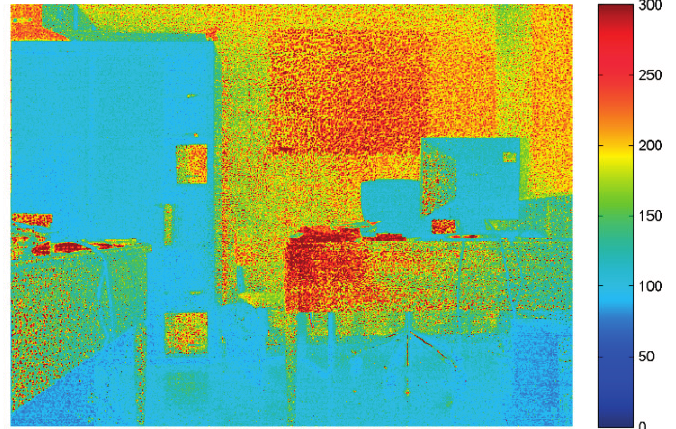
Figure 4. Standard deviation computed for each corresponding pixel for 100 subsequent IR images for Kinect 1.0.